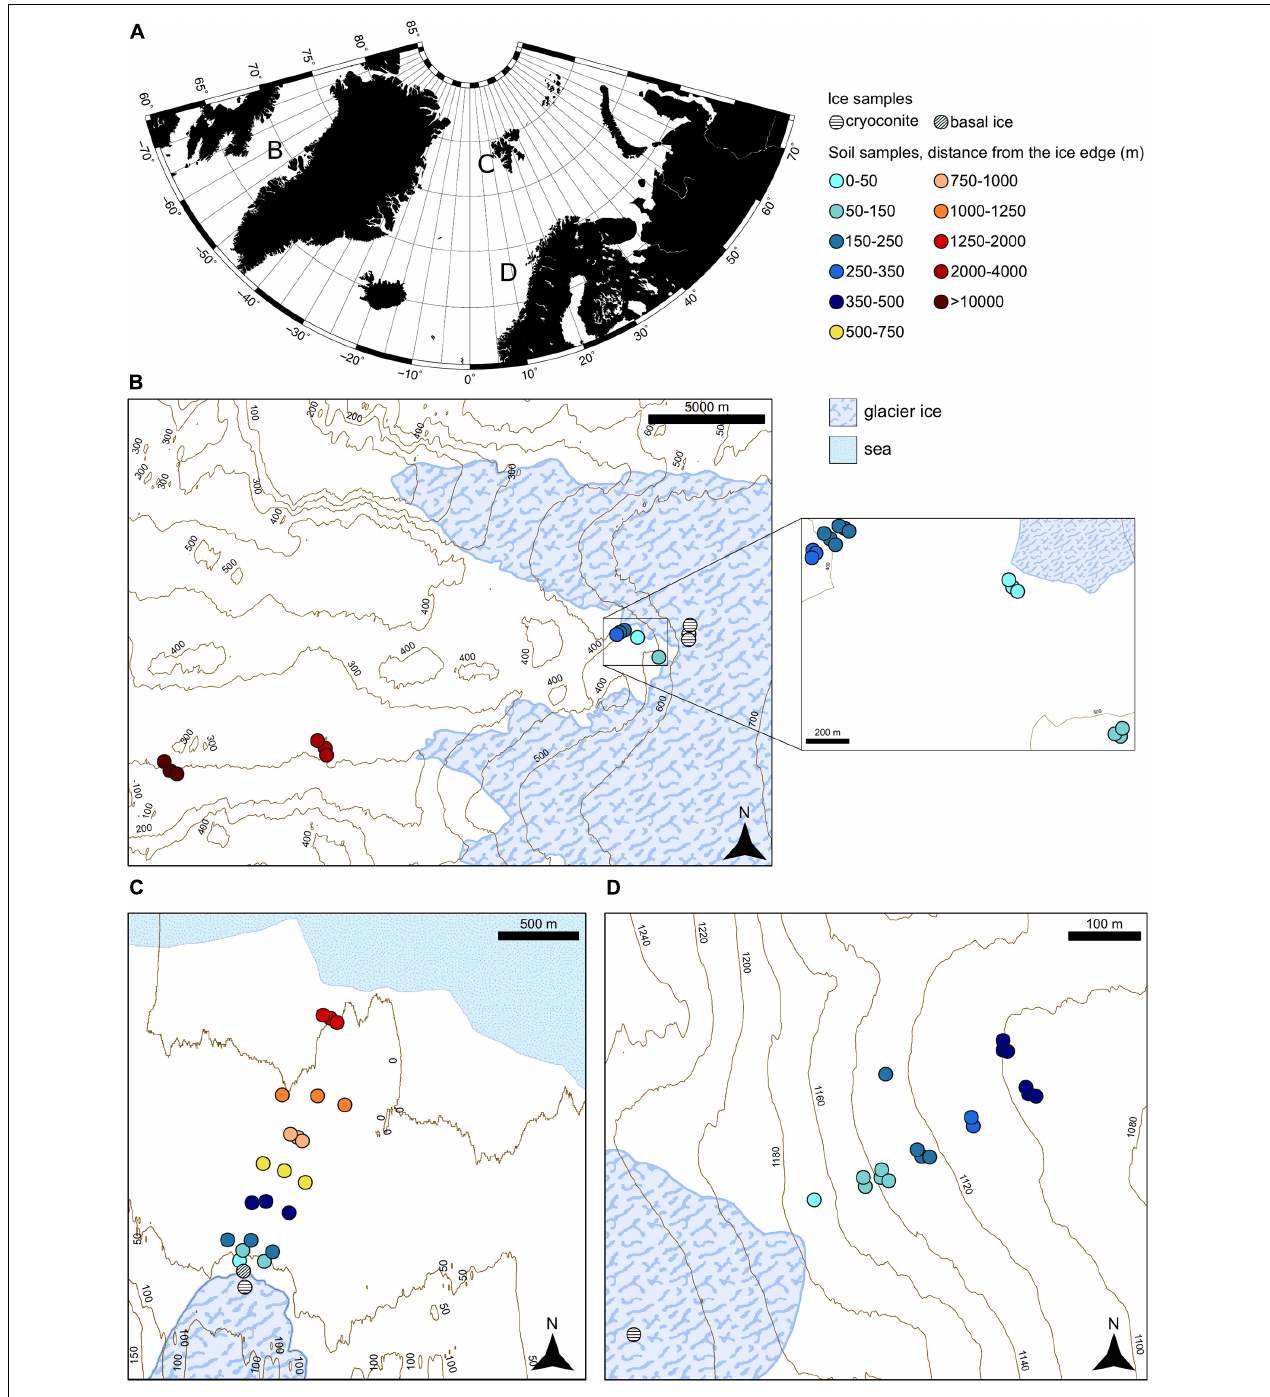
on the different forefield datasets: correlation with the sample distance from the ice edge was significant only in the SV and SW forefields with an r of 0.39 and 0.33, respectively ( p - value < 0.05; Table 2B